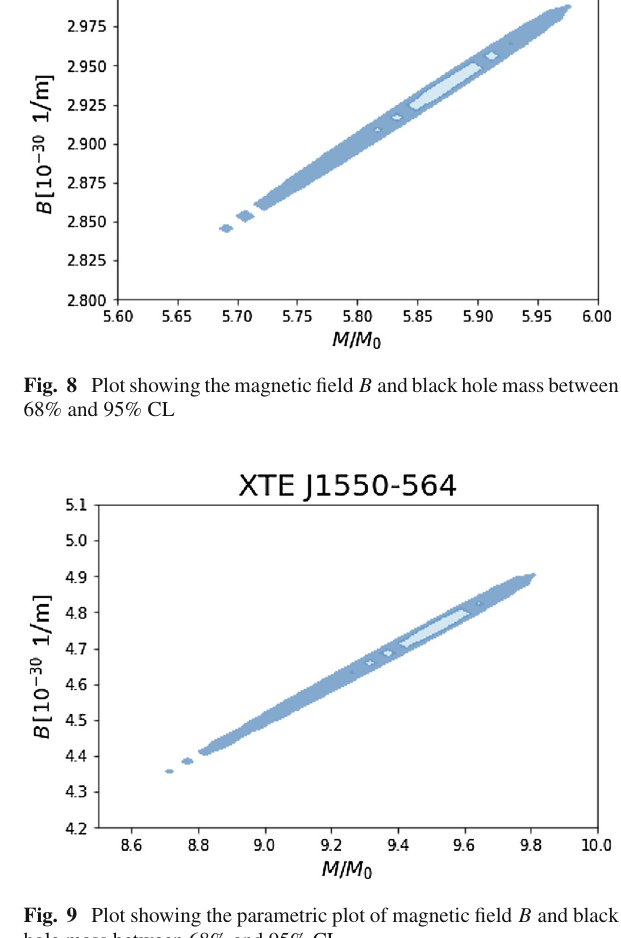
Fig. 9 Plot showing the parametric plot of magnetic field B and black hole mass between 68% and 95% CL The parametric plot between the magnetic field and the black hole mass is presented in Fig. 8.